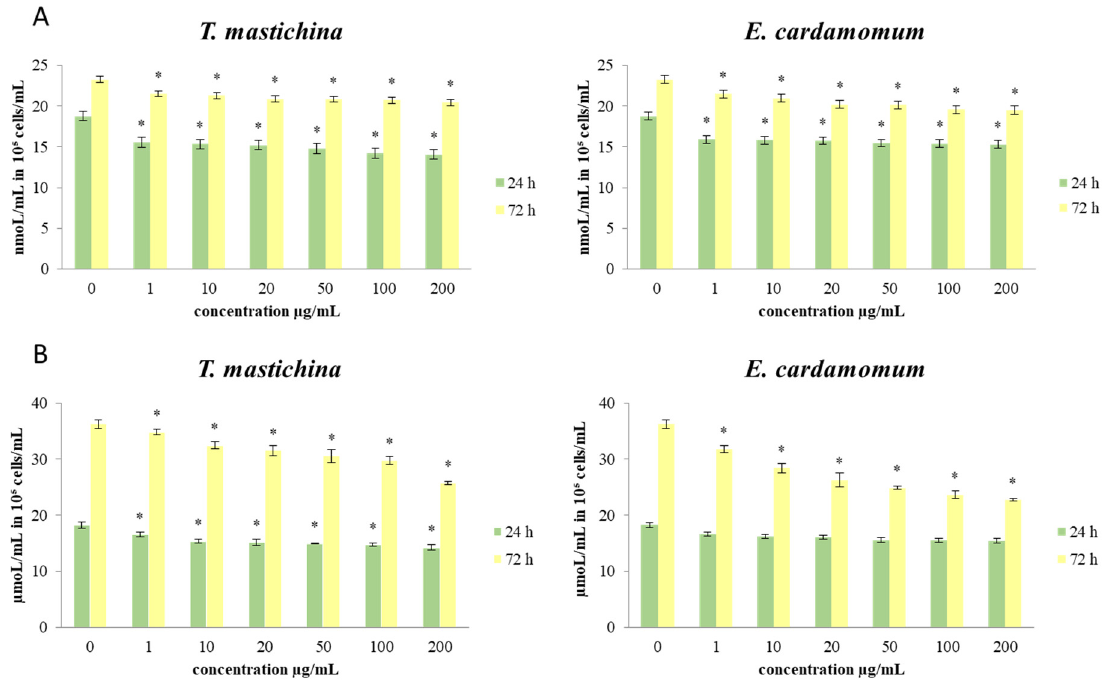
Figure 2. The effects of six concentrations of essential oils on the concentrations of ( A ) O 2 •− and ( B ) NO 2 − in MDA-MB-468 cells after 24 and 72 h of treatment. Results are presented as the mean of three independent experiments ± standard error; * p < 0.05 relative to control.